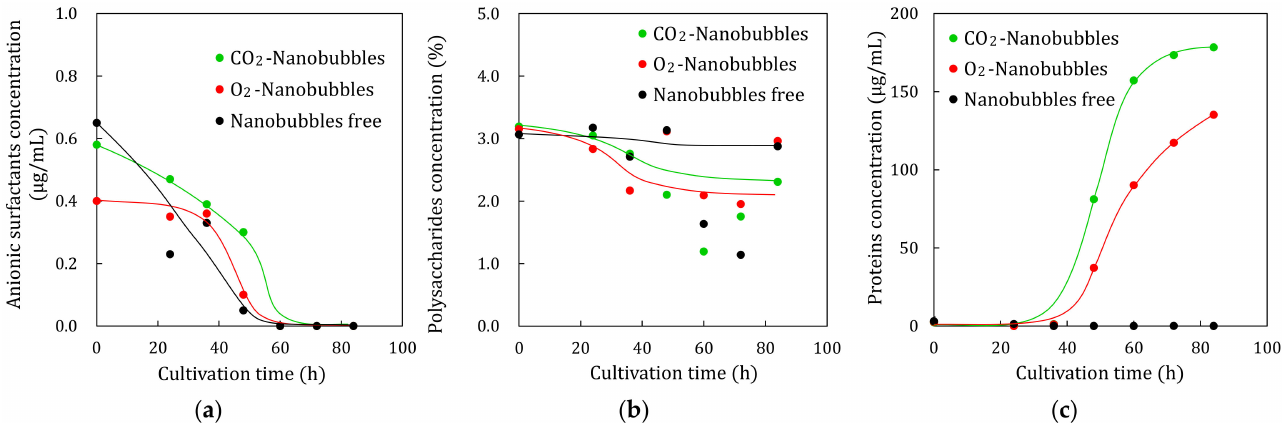
Figure 6. The temporal changes in the concentrations of bioproducts in each culture medium: ( a ) anionic surfactants; ( b ) polysaccharides; ( c )